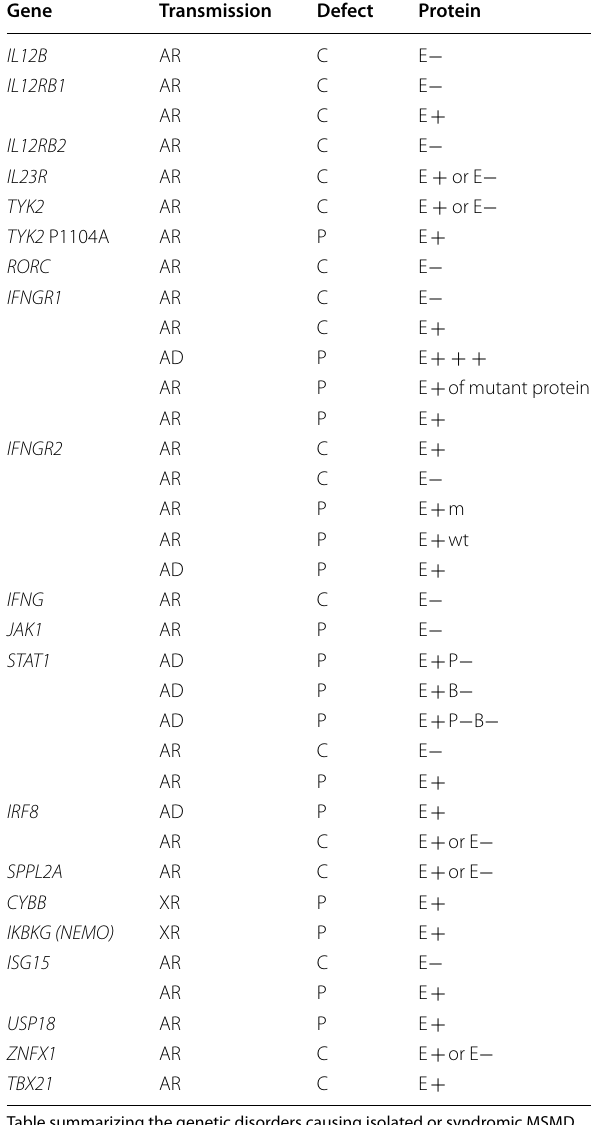
Table summarizing the genetic disorders causing isolated or syndromic MSMD. AD autosomal recessive, AR autosomal recessive, XR X-linked recessive, C complete, ( P partial. Mutant protein is (E ) expressed, (E ) not expressed or + − (E ) increased, (P ) not phosphorylated or (B ) unable to bind DNA, (wt) + + + − − wild